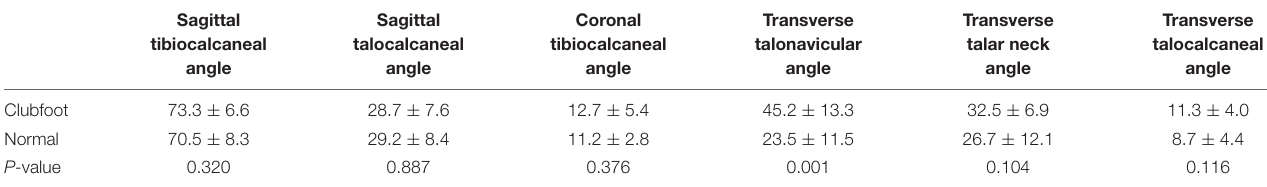
FIGURE 3 | Dorsal talonavicular subluxation in the sagittal plane of MRI (arrow). TABLE 1 | Six measurement parameters between clubfeet and normal